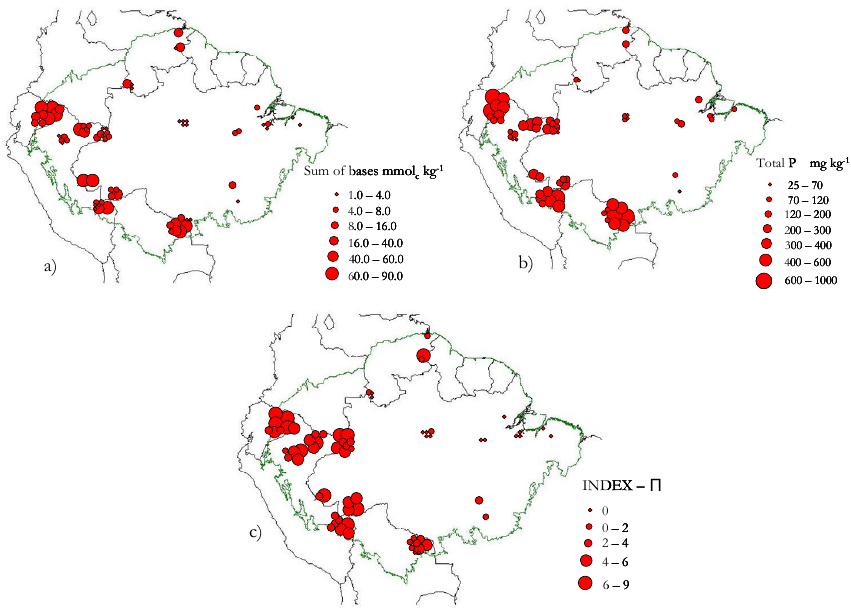
Fig. 2 Fig. 2. Distribution of chemical and physical properties of soils across Amazonia. (a) sum of bases; (b) total phosphorus and (c) index for soil physical properties ( 5 ). Size of circles represent concentration differences among sites, see legend for details. Table 3. Details for WRB lower classification levels within the